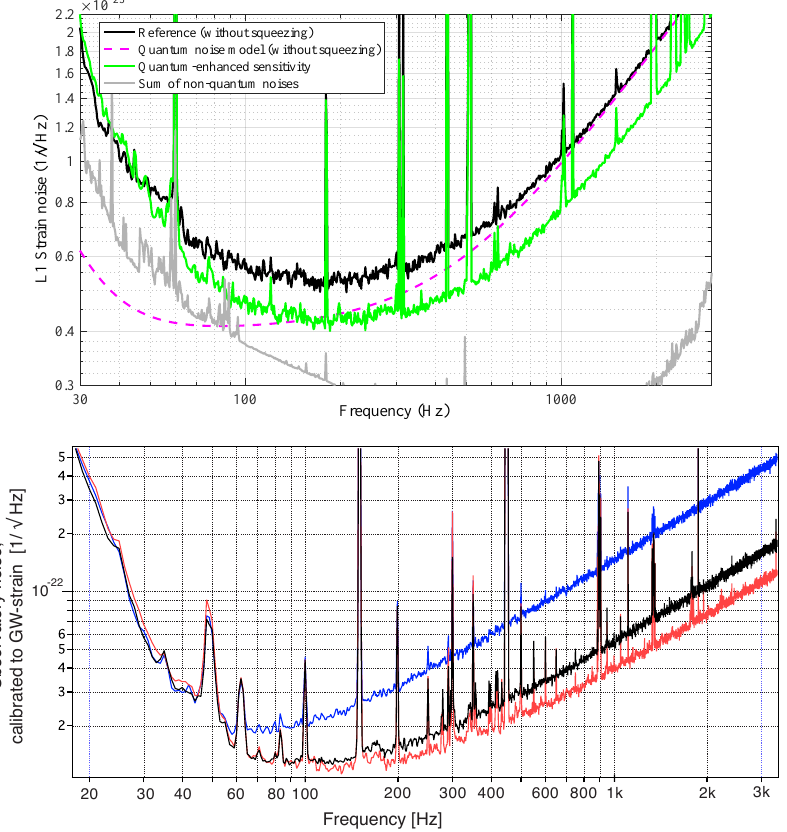
Figure 5. ( Top ) Improved sensitivity of the LIGO Livingston detector in the 3rd observing run, reproduced from [9]. The black trace shows the sensitivity without squeezing injected, while the green trace shows the 2.7 ± 0.1 dB shot noise reduction with squeezing injected. The dashed magenta line shows a model of quantum noise in the detector without squeezing injected, while the gray trace is an estimate of the other noises. ( Bottom ) Improved sensitivity of the Virgo interferometer in the 3rd observing run, reproduced from [10]. The black trace shows the sensitivity without squeezing injected, the red trace shows the 3.2 ± 0.1 dB shot noise reduction with squeezing injected, and blue shows the 8.5 ± 0.1 dB increase in shot noise when the squeezing quadrature is rotated by 90